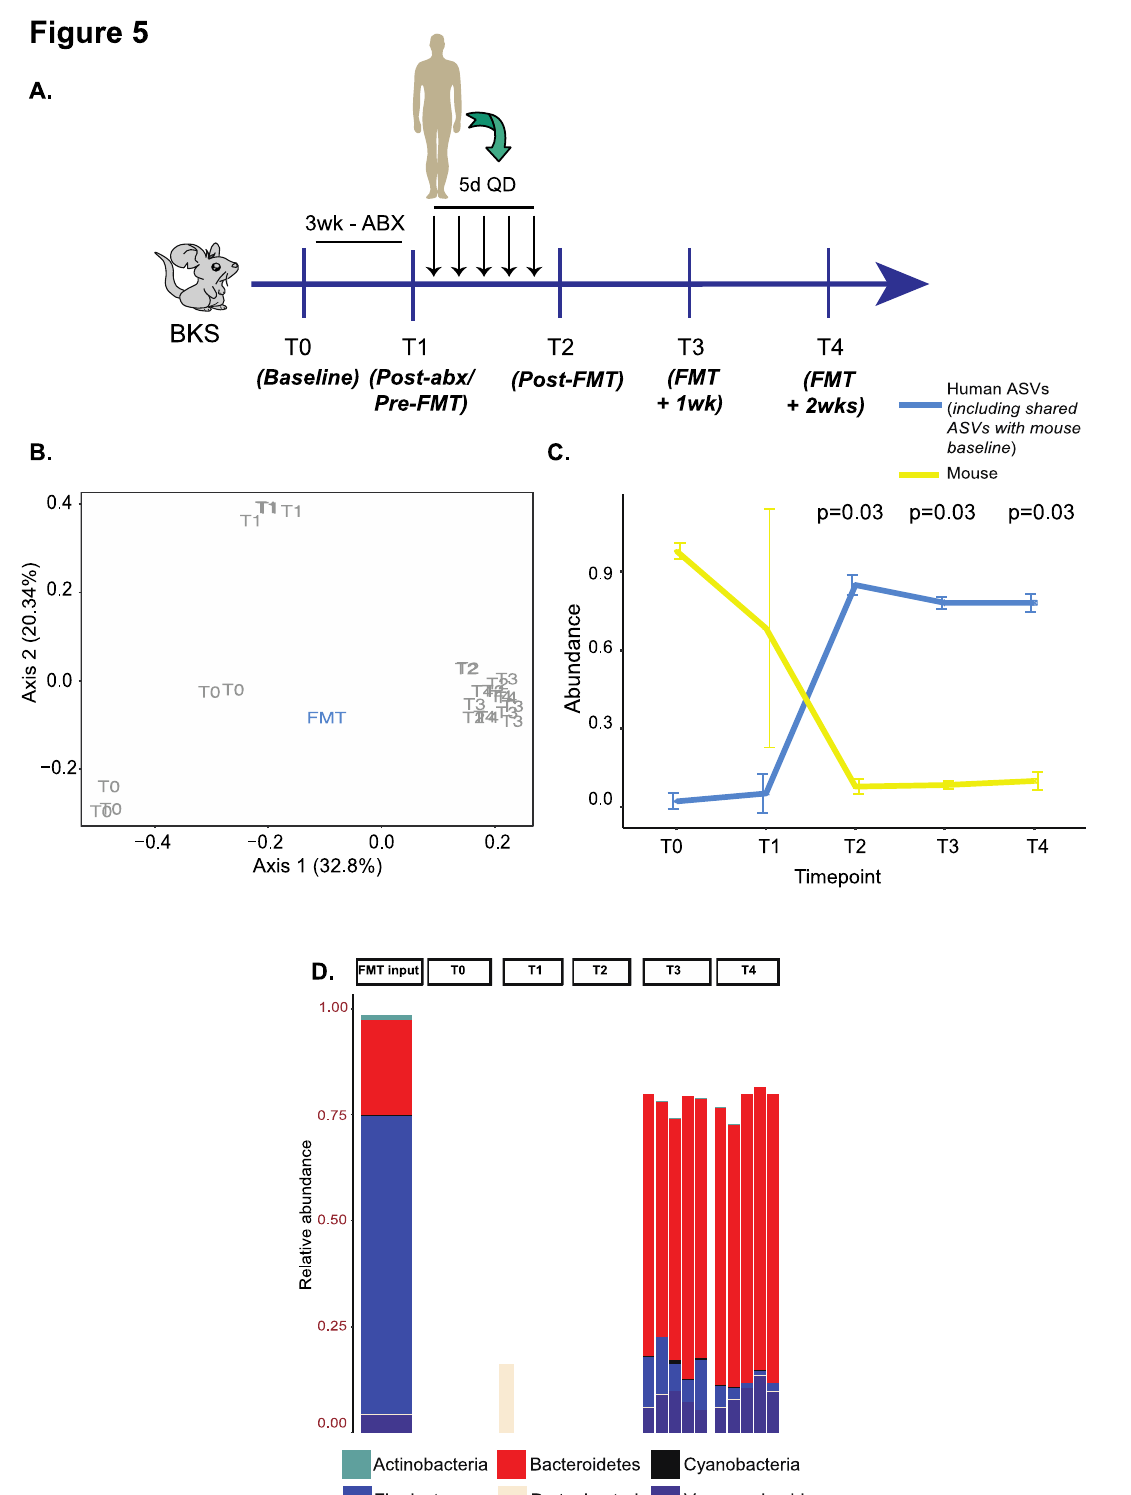
Figure 5. Validation experiment in BKS mice using the G6 regimen. ( A ) Experimental schema. ( B ) PCOA plot of unweighted UniFrac beta-diversity distances with p -values calculated by ANOSIM. ( C ) Line plot to compare changes in ‘human’ and ‘mouse’ ASV abundances over time. The p -value is calculated from a one-sided paired Wilcoxon signed-rank test and adjusted for false discovery rate. ( D ) Stacked bar plot showing engraftment of phyla uniquely derived from the input material in recipient